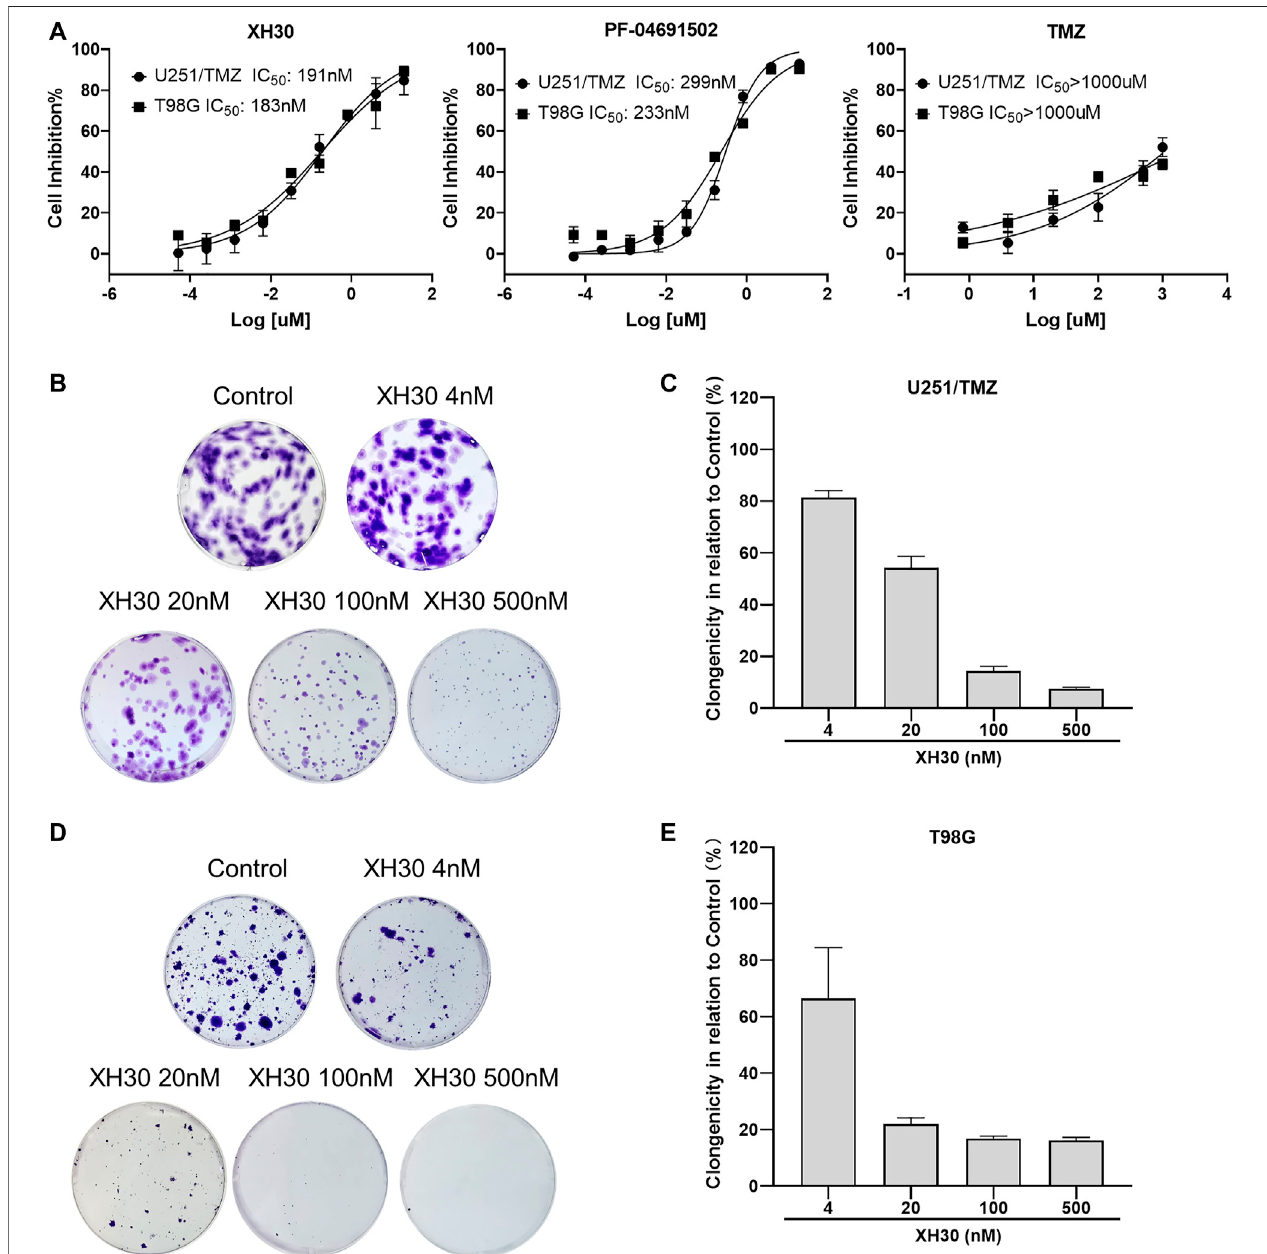
FIGURE 1 | The PI3K inhibitor XH30 inhibited cell proliferation in temozolomide (TMZ) – resistant glioblastoma multiforme (GBM) cells. (A) The IC 50 values of XH30, PF-04691502 (control), and TMZ in TMZ-resistant GBM cells over 72 h. Data are presented as means ± SD, n (cid:1) 3. (B,D) Colony formation assay of XH30 in TMZ- resistantU251/TMZandT98Gcells,respectively.Representativeimagesareshownforeachgroup. (C,E) TheinhibitionratioofcolonyformationassayofXH30inU251/ TMZ and T98G cells, respectively. Data are presented as means ± SD, n (cid:1) 3.